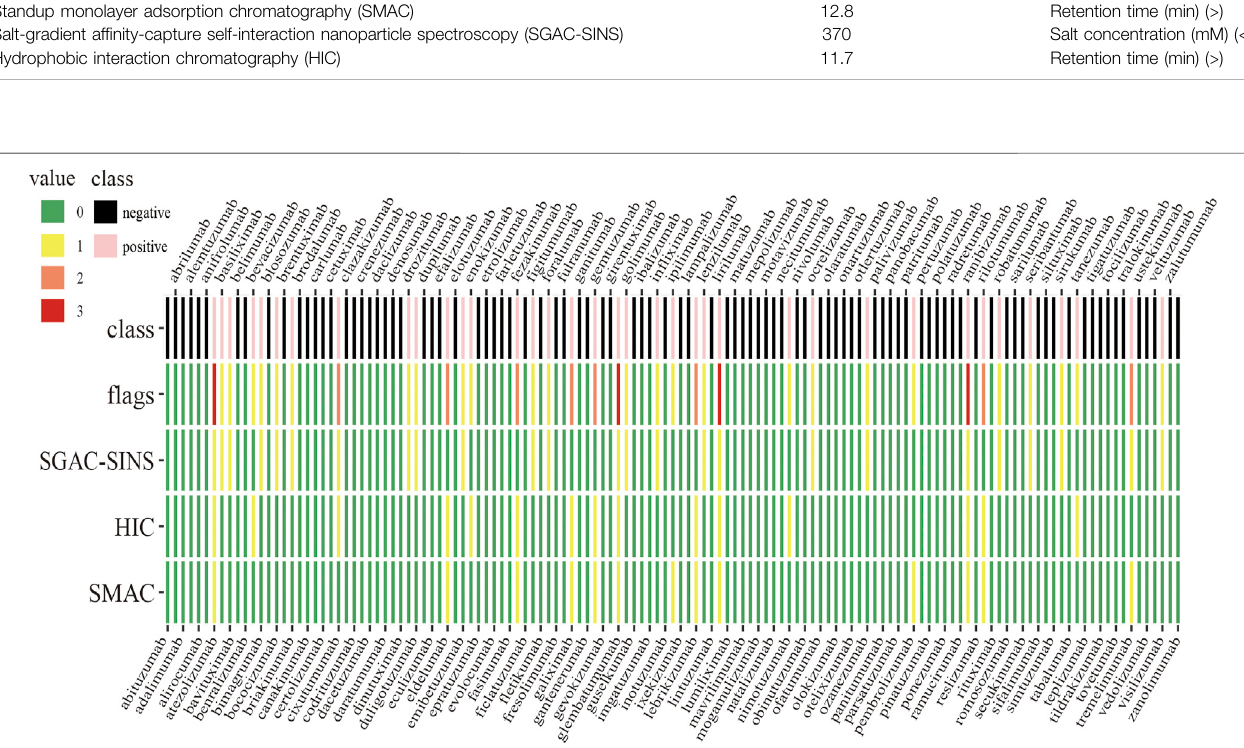
TABLE 1 | Three experimental thresholds for evaluating the hydrophobic interaction of antibodies (Jain et al., 2017b). Assay